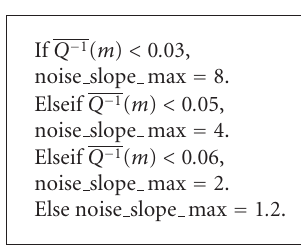
Algorithm 1: Computation of noise slope max.